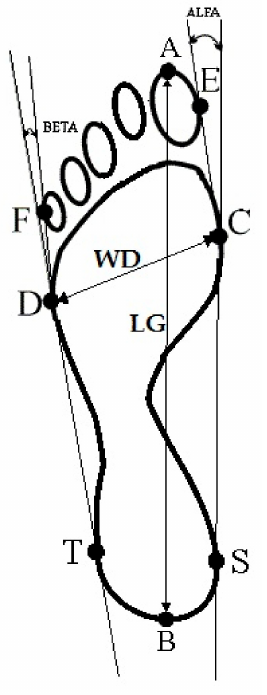
Figure 1. Procedure for determining the feet structure indices (i.e., foot length, foot width, hallux valgus angle, the angle of the varus deformity of the fifth toe, and the Wejsflog